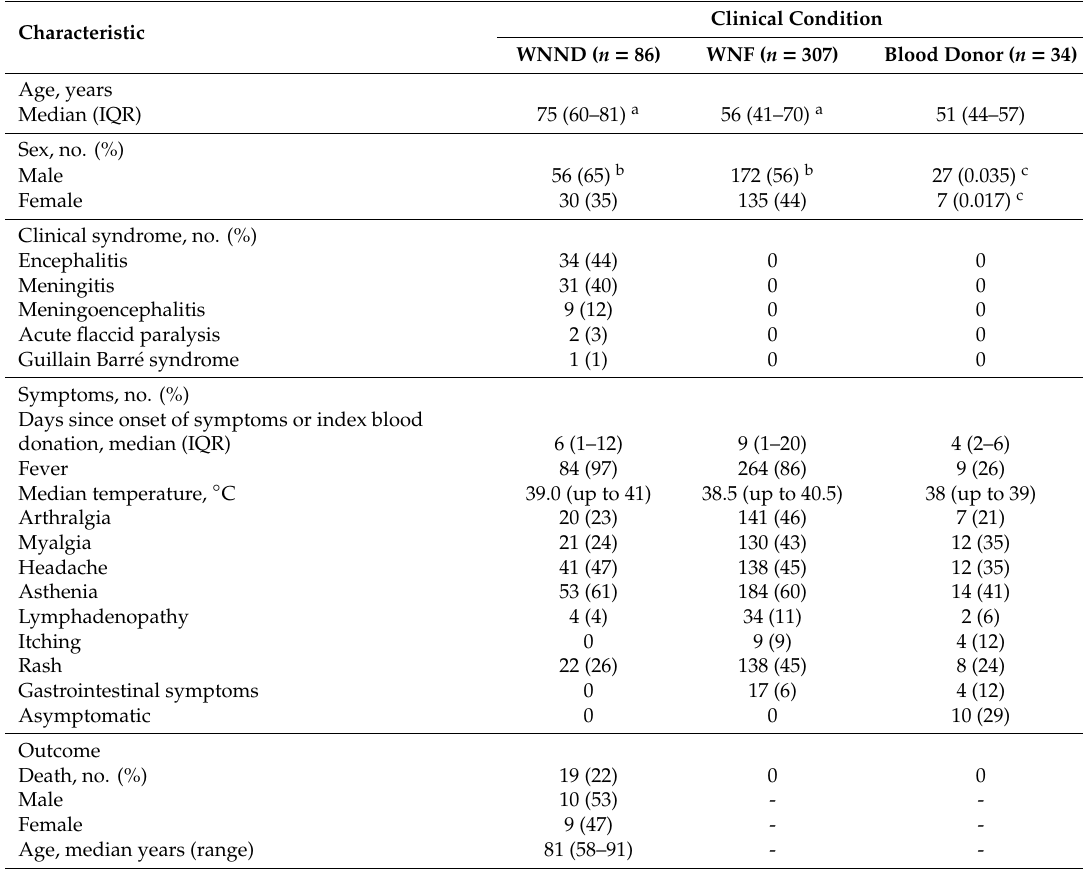
Table 1. Demographic and clinical features of subjects with confirmed West Nile virus (WNV) infection, Veneto region,